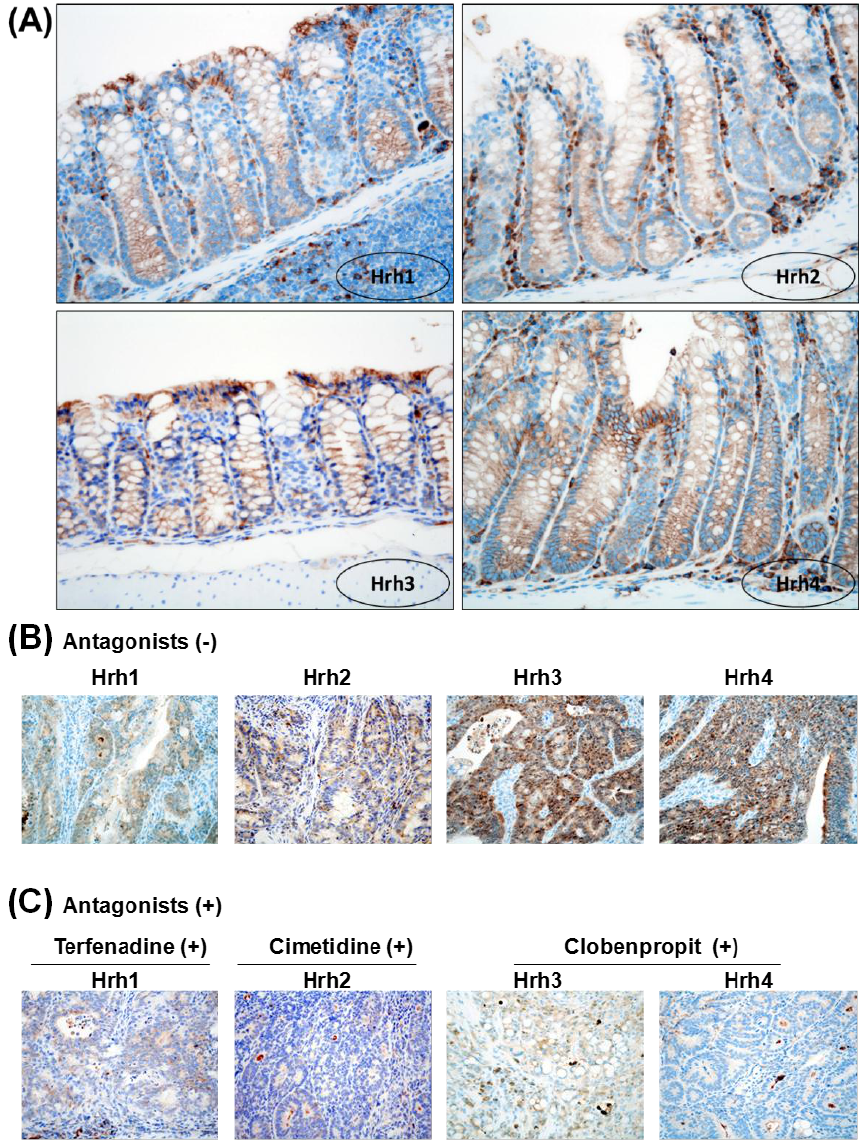
Figure 3. ( A ) Immunohistochemical expression of Hrh1, Hrh2, Hrh3 and Hrh4 in normal crypts. H